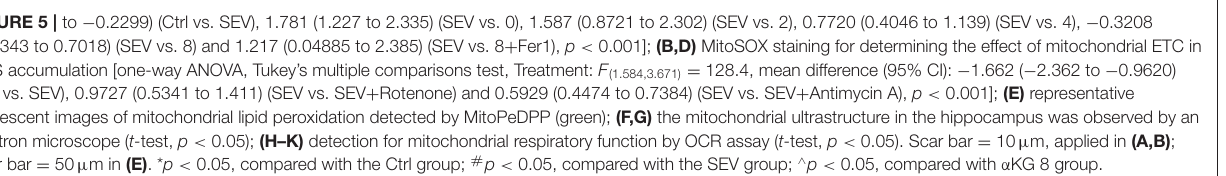
FIGURE 5 | to − 0.2299) (Ctrl vs. SEV), 1.781 (1.227 to 2.335) (SEV vs. 0), 1.587 (0.8721 to 2.302) (SEV vs. 2), 0.7720 (0.4046 to 1.139) (SEV vs. 4), − 0.3208 ( − 1.343 to 0.7018) (SEV vs. 8) and 1.217 (0.04885 to 2.385) (SEV vs. 8 + Fer1), p < 0.001]; (B,D) MitoSOX staining for determining the effect of mitochondrial ETC in ROS accumulation [one-way ANOVA, Tukey’s multiple comparisons test, Treatment: F (1.584,3.671) = 128.4, mean difference (95% CI): − 1.662 ( − 2.362 to − 0.9620) (Ctrl vs. SEV), 0.9727 (0.5341 to 1.411) (SEV vs. SEV + Rotenone) and 0.5929 (0.4474 to 0.7384) (SEV vs. SEV + Antimycin A), p < 0.001]; (E) representative fluorescent images of mitochondrial lipid peroxidation detected by MitoPeDPP (green); (F,G) the mitochondrial ultrastructure in the hippocampus was observed by an electron microscope ( t- test, p < 0.05); (H–K) detection for mitochondrial respiratory function by OCR assay ( t- test, p < 0.05). Scar bar = 10 µ m, applied in (A,B) ; Scar bar = 50 µ m in (E) . * p < 0.05, compared with the Ctrl group; # p < 0.05, compared with the SEV group; ∧ p < 0.05, compared with α KG 8